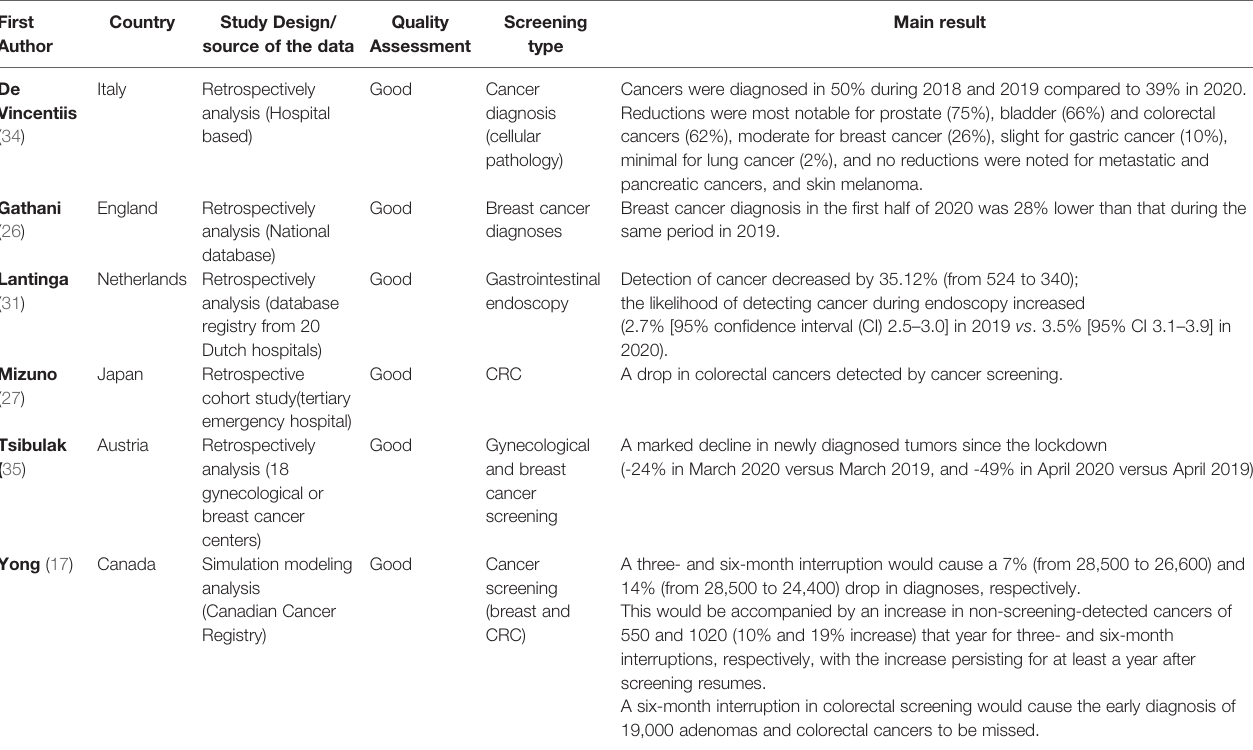
TABLE 2 | Impact of COVID-19 on cancer diagnosis.